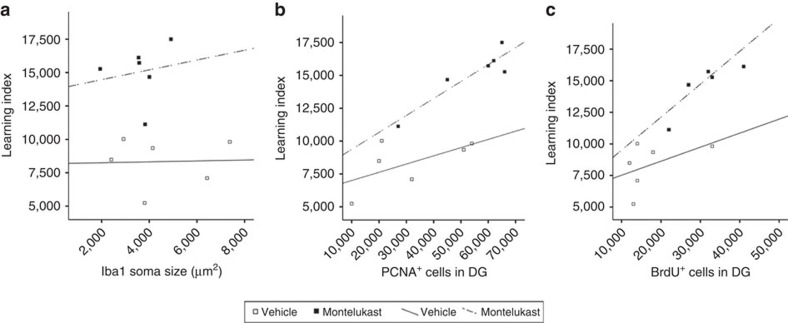
Montelukast-mediated cognitive improvements in old rats correlate with increased neurogenesis.(a) Correlation analysis showed that the individual learning scores of old vehicle-treated and old montelukast-treated rats were independent of the soma size of Iba1+ cells in the DG (vehicle: R2=0.001; y=81.79+0.034*x; montelukast: R2=0.027; y=137.35 +0.368*x). (b) The correlation coefficient between learning success and number of PCNA+ cells revealed a tendency towards correlation in the old vehicle-treated rats (R2=0.361; y=63.75+0.063*x). Montelukast provoked a stronger correlation and led to a steeper slope of the regression line (R2=0.843; y=80.8+0.129*x). (c) Similarly, learning and the number of BrdU+ cells showed a trend for correlation in vehicle-treated old rats (R2=0.225; y=64.11+0.111*x), and again, this correlation was strengthened in montelukast-treated rats (R2=0.601; y=69.01+0.261*x). N per group: 6 (old vehicle), 6 (old montelukast). Correlation analysis was performed using the Pearson product moment correlation test. DG, dentate gyrus.